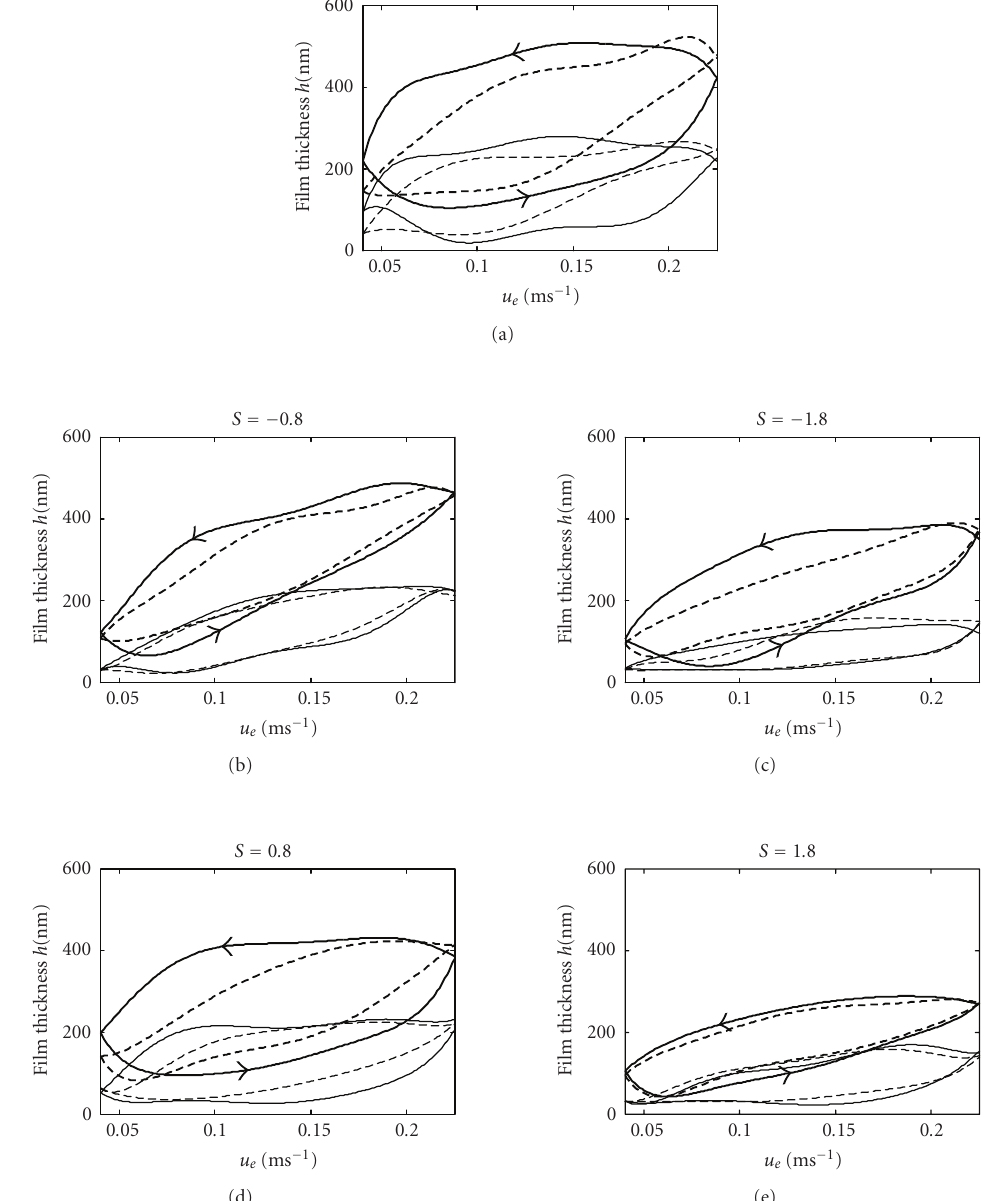
Figure 17: Central (thick lines) and minimum (thin lines) film thickness for 0.25 Hz (dashed lines) and 1Hz (solid lines) for di ff erent values of S : S = 0 (a), S = − 0.8 (b), S = − 1.8 (c), S = +0.8 (d), and S = +1.8